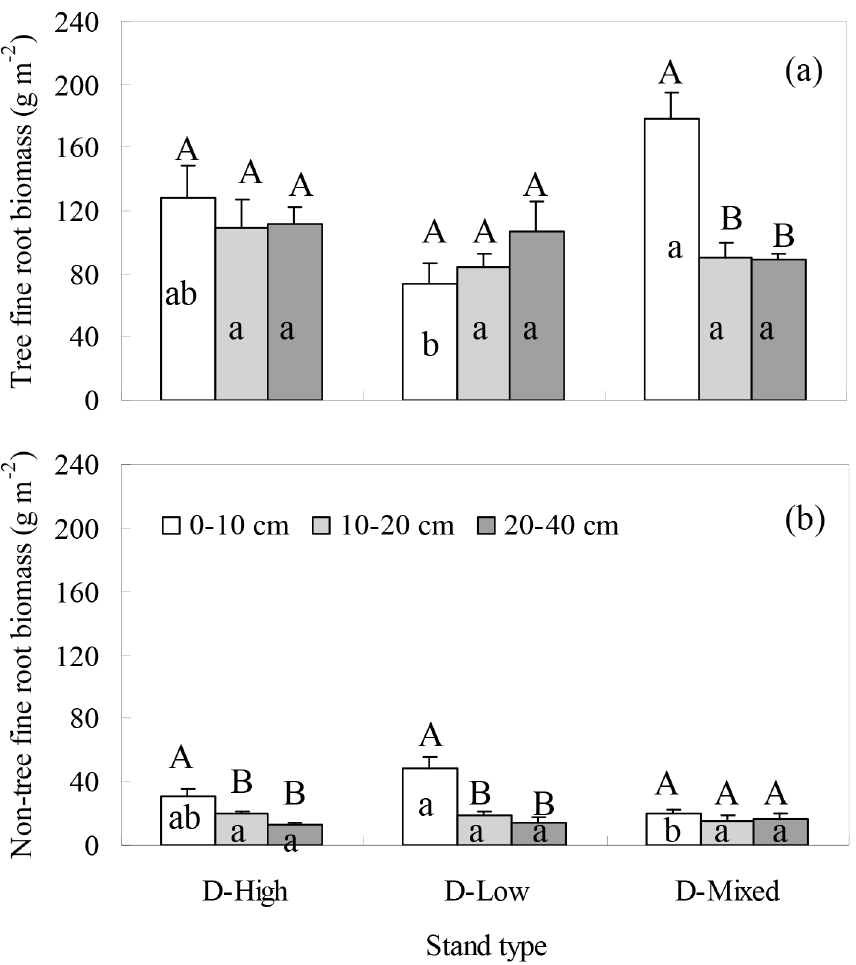
Fig 1. The FRBs of (a) tree and (b) non-tree species at Datian along the soil profile for five plot replicates per stand and nine sampling locations per plot. Error bar represents one standard error of the mean. Different upper-case letters denote significant differences among soil depths within stand types ((a) D- mixed: F = 20.629, P < 0.001; (b) D-High: F = 9.707, P = 0.003; D-Low: F = 17.259, P < 0.001). Different lower- case letters denote significant differences among stand types within soil depths ((a) 0-10cm: F = 9.108, P = 0.004; (b) 0 – 10 cm: 8.698, P =